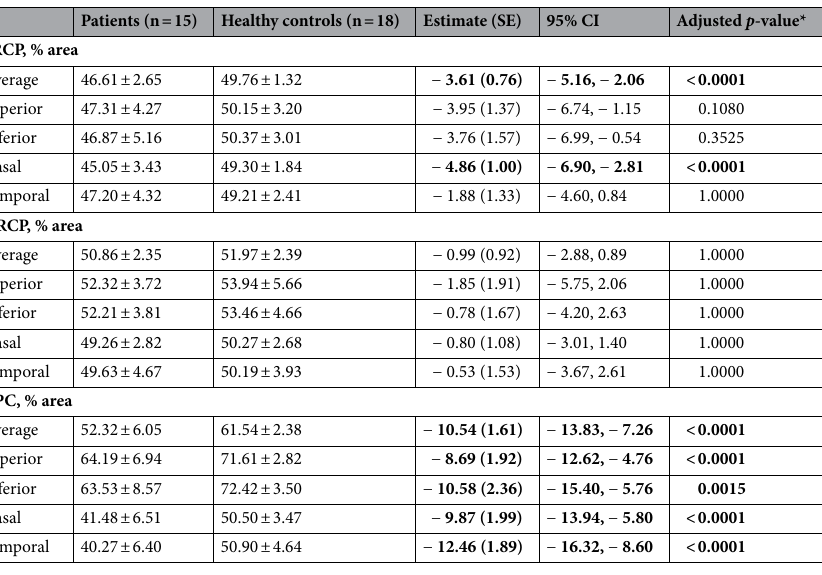
Table 3. Comparison of superficial, deep retinal capillary plexus and radial peripapillary capillary segment vessel densities between patients with pediatric and juvenile CP and healthy controls. SRCP superficial retinal capillary plexus, DRCP deep retinal capillary plexus, RPC radial peripapillary capillary, SE standard error, CI confidence interval. Values are shown as mean ± standard deviation. * P- values were estimated by linear regression analysis with adjustment for age and spherical equivalent refractive errors and Bonferroni correction magnified by 15. Boldface indicates statistical significance.